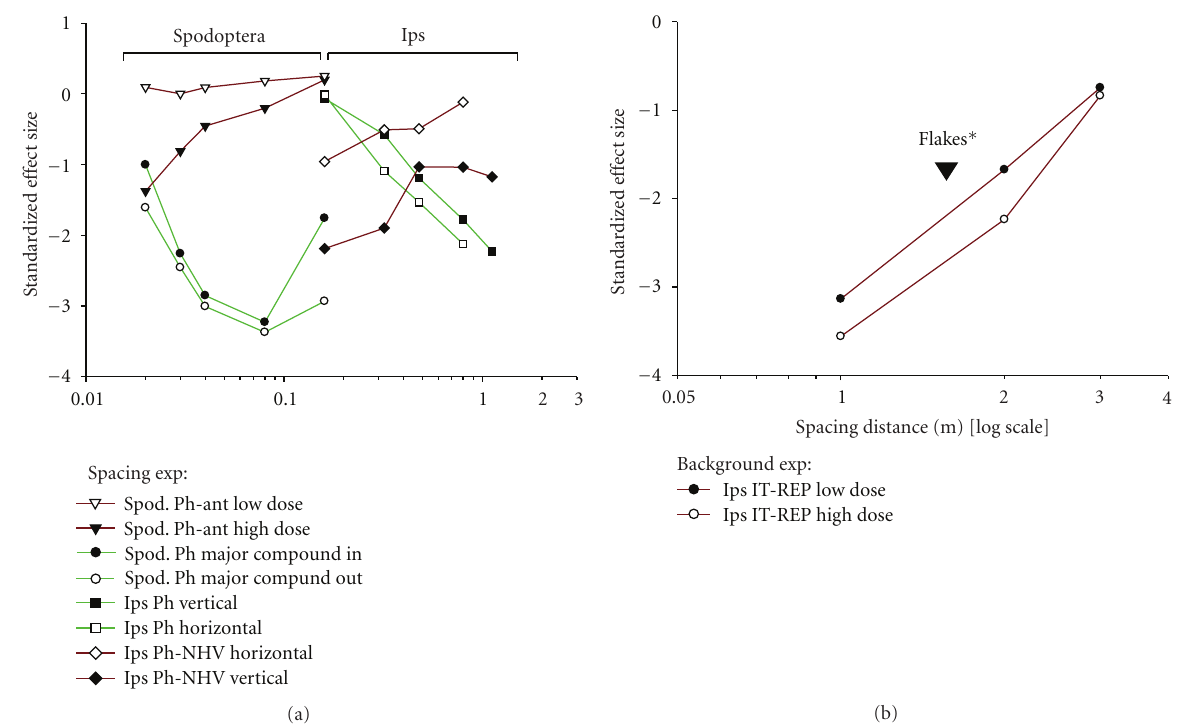
Figure 8: (a) The e ff ect of spacing between attractant and antiattractant sources on trap catches of Ips typographus and Spodoptera littoralis , illustrated by measures of e ff ect size ( Hedges’ unbiased g ). The e ff ect size provides a measure of a biological treatment e ff ect by scaling the di ff erence between the treatment and the control means, with the pooled standard deviation for those means. E ff ect sizes further from zero than 0.8 are regarded as strong e ff ects. In all experiments, the pheromone bait alone (zero distance between components) was the control. The zero cm spacing distance in experiments involving antiattractants is omitted for clarity. (b ) E ff ect sizes in the Ips antiattractant background experiments using nonhost volatile dispensers at eight positions, or flakes around the trap. ∗ Flakes were evenly distributed on the ground 0–2m from the trap. Thus, this treatment is “not to scale” on the x -axis. Ph = pheromone; Ant = Spodoptera pheromone antagonist; NHV = nonhost volatiles; IT-REP = semicommercial Ips typographus repellent dispenser (from [69], with permission from the